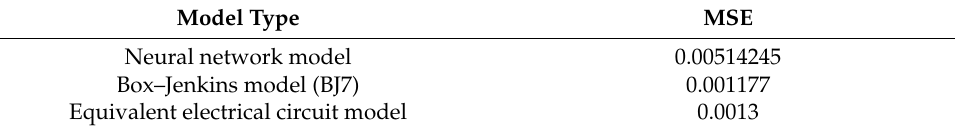
Table 4. Different models performance based on MSE using MIX driving